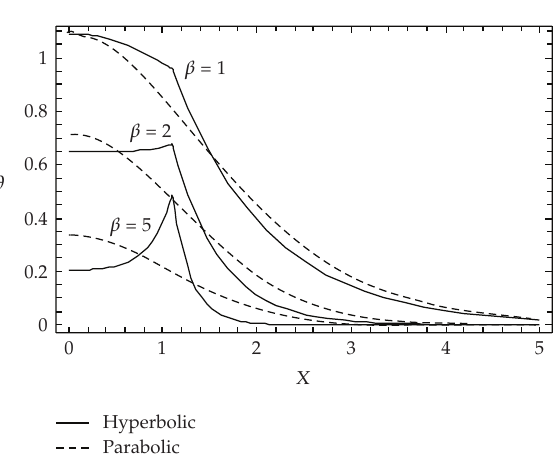
Figure 7: Dimensionless temperature distributions at η (cid:5) 1 for the instantaneous heat source and various values of β ; φ (cid:3) η (cid:4) (cid:5) δ (cid:3) η (cid:4) , ψ 0 (cid:5) 1 , and U (cid:5) 0 . 1 .